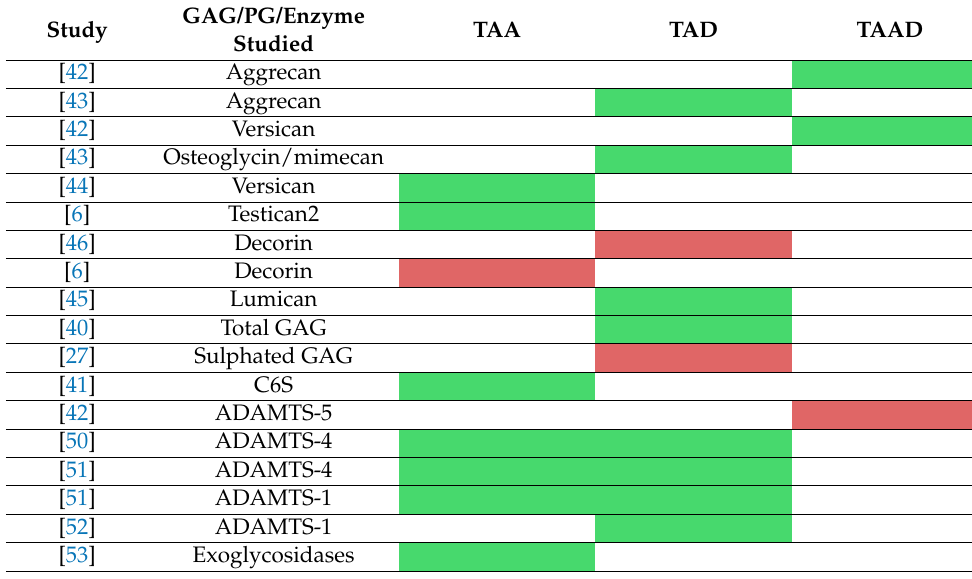
Table 3. Studies where a difference was observed between normal and TAAD human diseased tissue. Each study is included with the GAG/PG/Enzyme presented comparing the human control groups vs. thoracic aortic aneurysm (TAA), thoracic aortic dissection (TAD) or thoracic aneurysm and dissection group (TAAD). Red indicates an observed decrease and green an observed increase in the level of GAG/PG/Enzyme compared with control. GAG/PG/Enzyme Study TAA TAD Studied